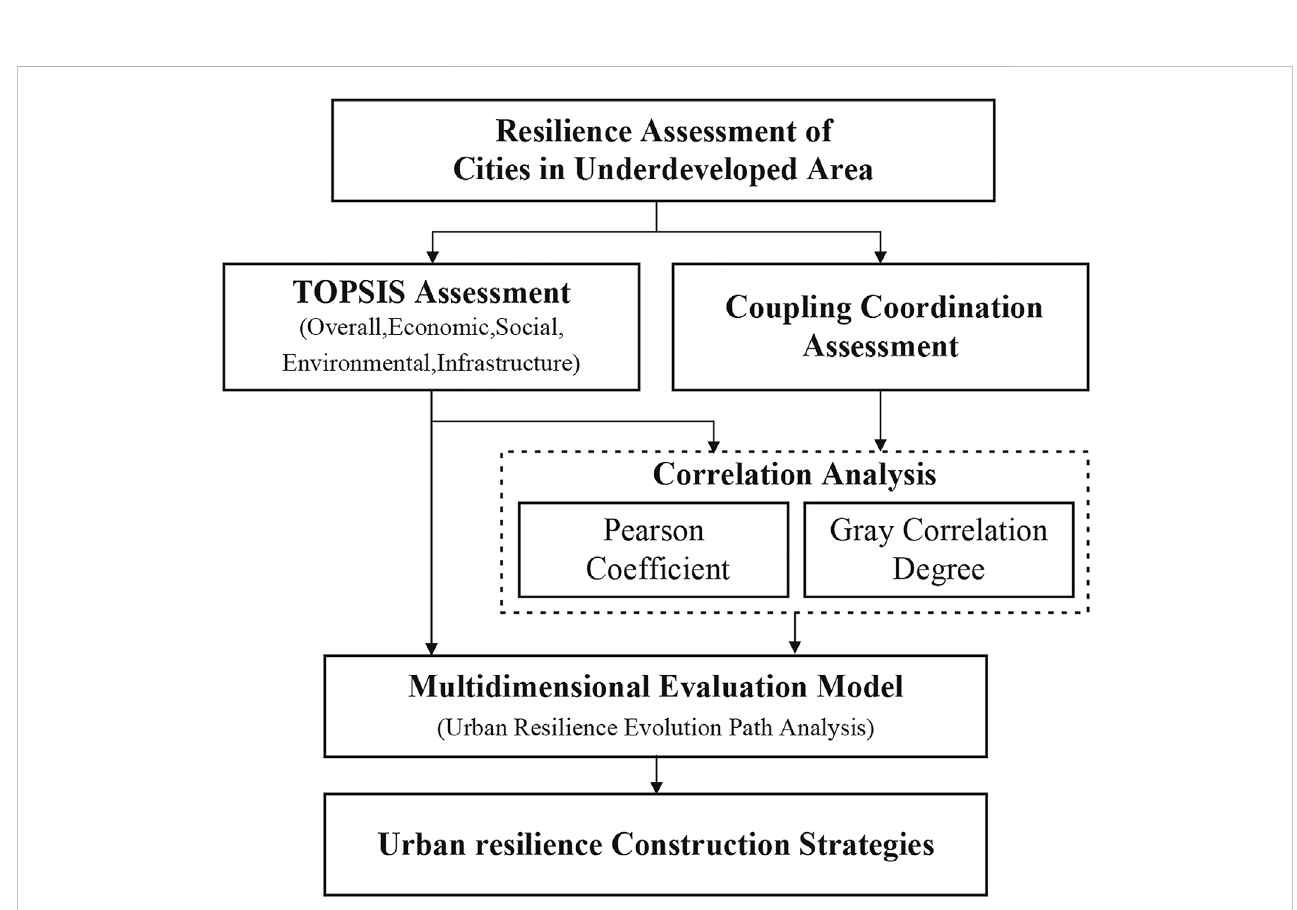
FIGURE 2 Framework for quantitative evaluation